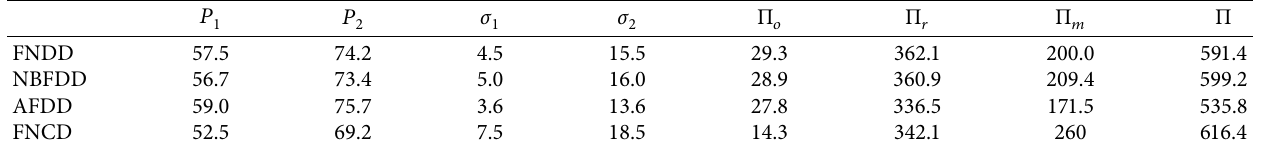
Table 5: Optimal decision values and profit values of four